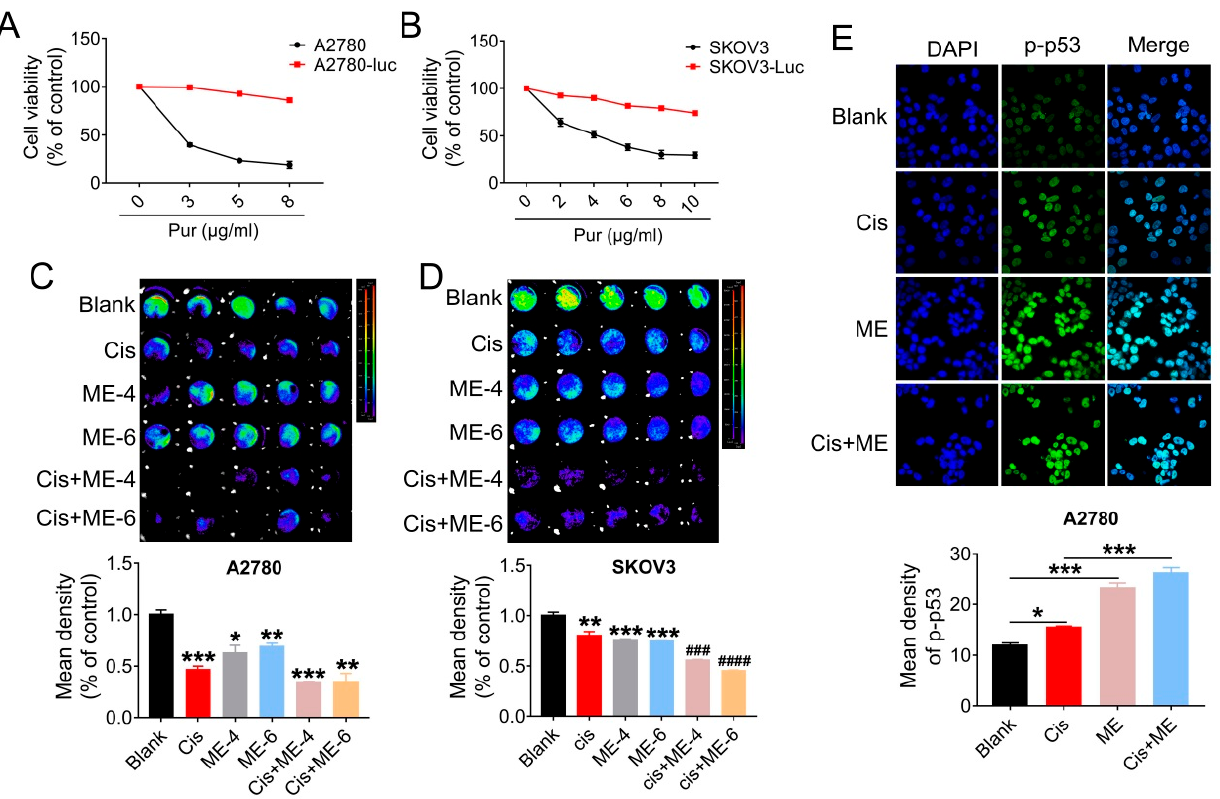
Figure 3. ME/cisplatin combination therapy promotes cell apoptosis in ovarian cancer. A2780 and SKOV3 cells were infected with lentiviral particles to express luciferase, and then treated with MEs/cisplatin. ( A ) A2780 and ( B ) SKOV3 cells were treated with different concentrations of puromycin to verify the transfection efficiency of luciferase. Cell viability was assayed using a CCK-8 kit. ( C ) Luciferase-positive A2780 and ( D ) SKOV3 were analyzed using Living Image software and a GloMax ® 96-microplate luminometer. The lower panels show the results of the quantitative analysis. * p ≤ 0.05, ** p ≤ 0.01, *** p ≤ 0.001 vs. blank; ### p ≤ 0.001, #### p ≤ 0.0001 vs. cis. ( E ) Levels of p-p53 in A2780 cells were measured by immunofluorescence staining (400 × ). The lower panel shows the results of the quantitative analysis of p-p53 in A2780. * p ≤ 0.05, *** p ≤ 0.001. Three independent experiments were performed with similar results. Data are shown as mean ±